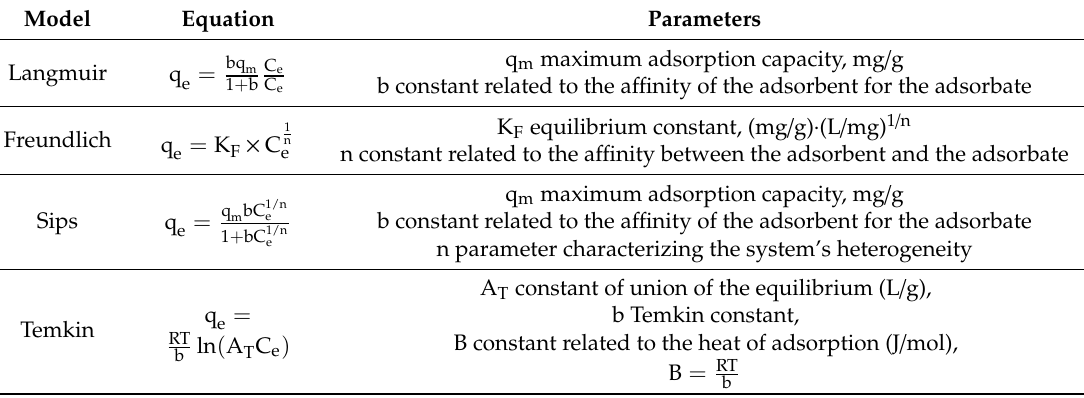
Table 4. Representative equations and parameters of the four selected models for the study of the equilibrium process.